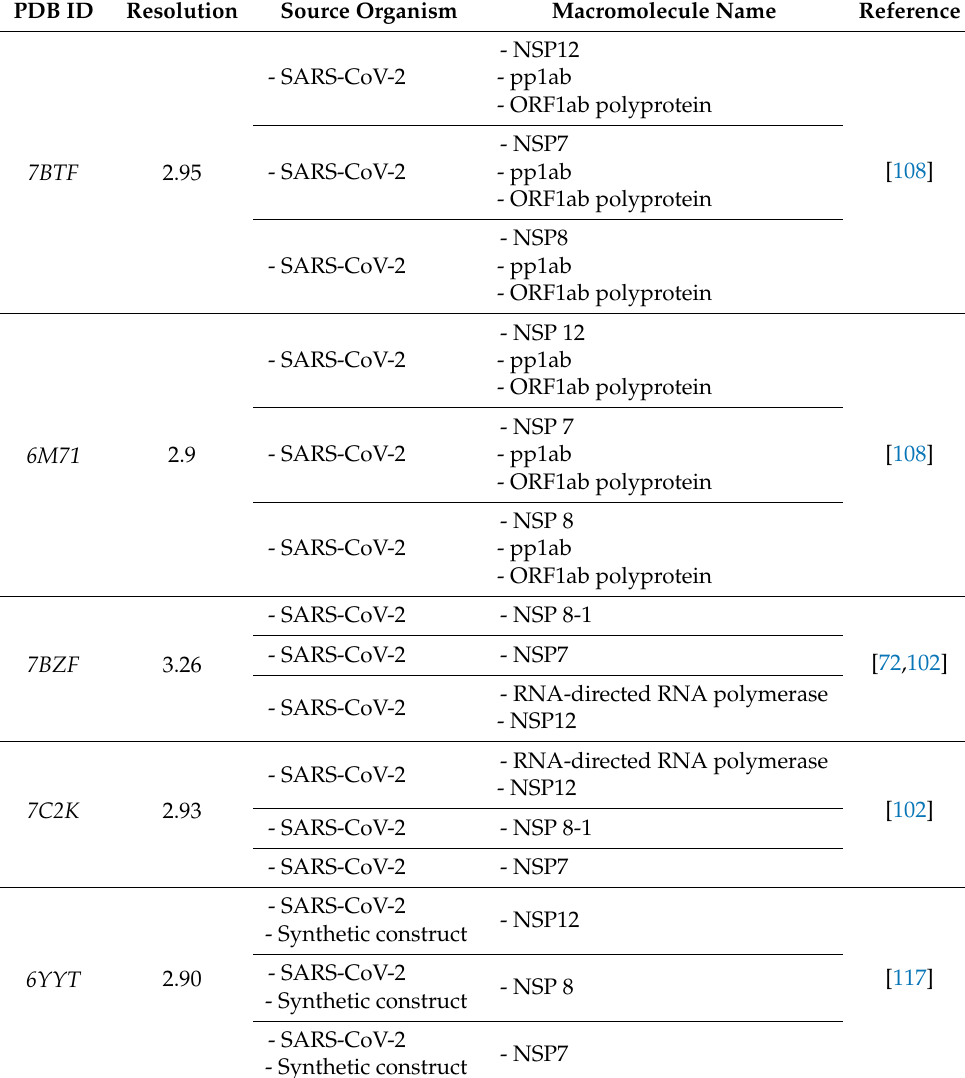
Table 4. The known 3D structures of RNA-dependent RNA polymerase (RdRp) available on protein data bank (PDB). PDB